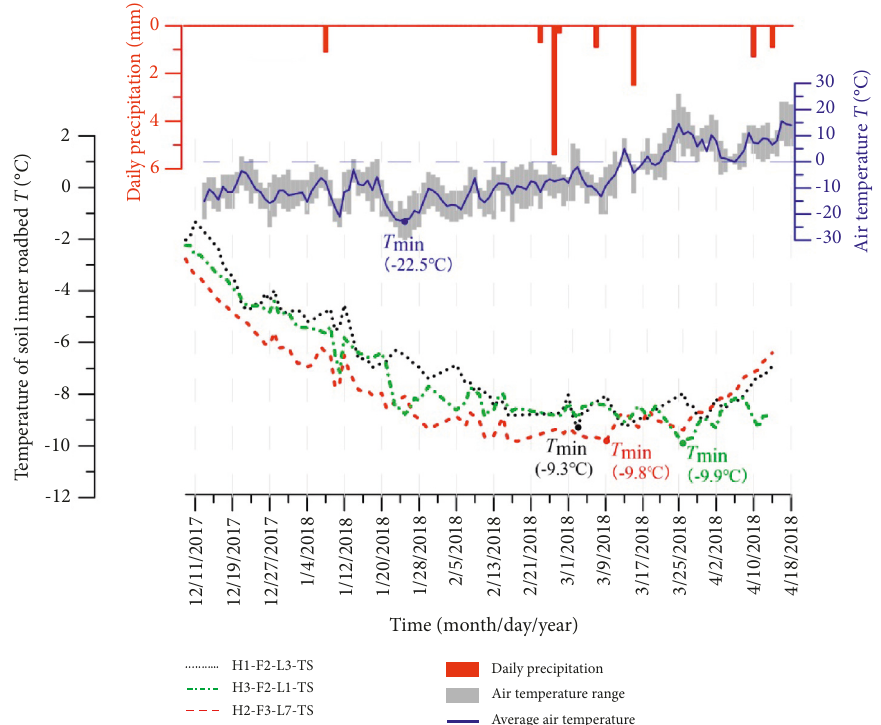
Figure 7: Curves of the soil temperature of the F2 layer in the roadbed under climatic